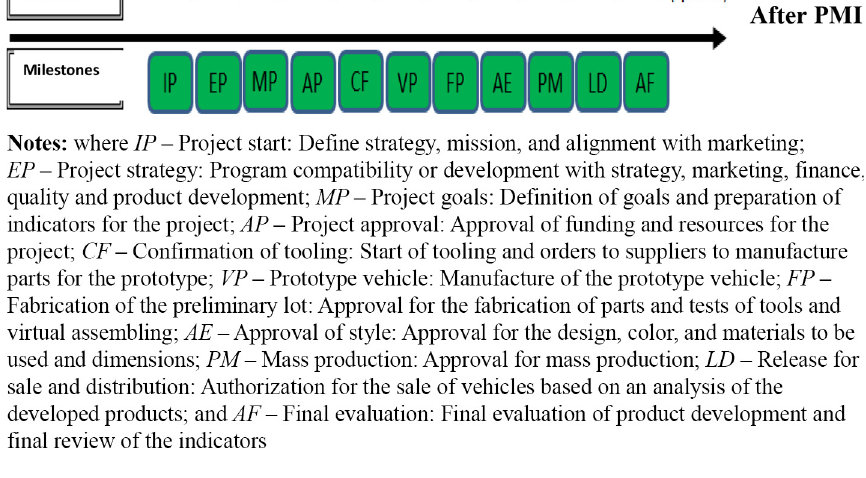
Figure 4. Timeline for